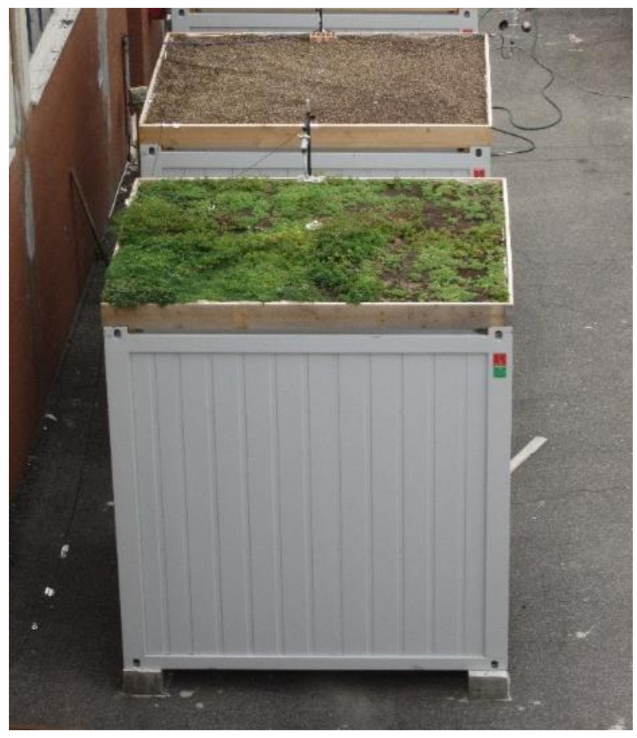
Figure 7. Outdoor test cells (TVSOIL and